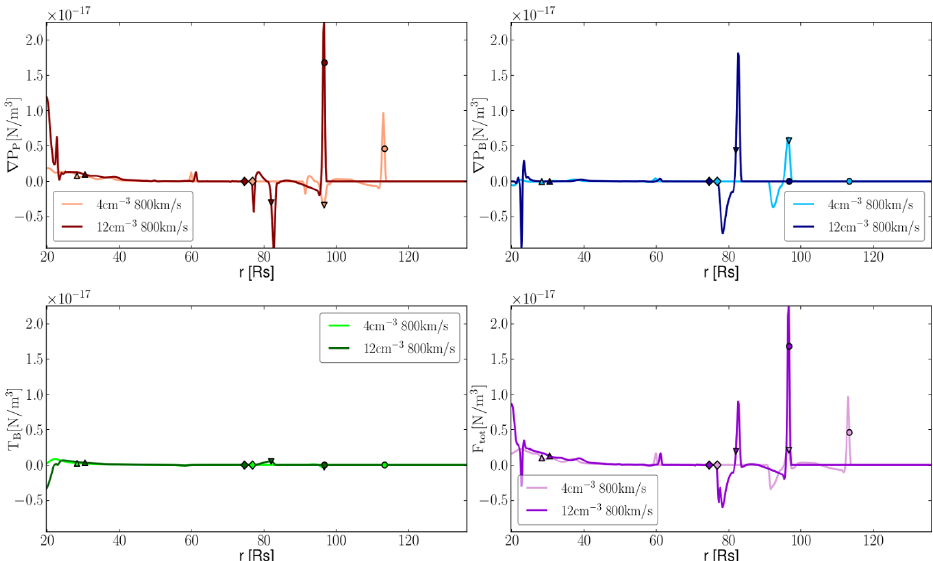
Figure 6. Forces in the equatorial plane at t = 20 h for a medium velocity normal CME ejected in low and high density background winds. Upper left panel: ∇ P P . Upper right panel: ∇ P B . Lower left panel: T B . Lower right panel: F tot . Locations of the shock, magnetic cloud edges and magnetic cloud centre are represented by circles, triangles and diamonds, respectively.